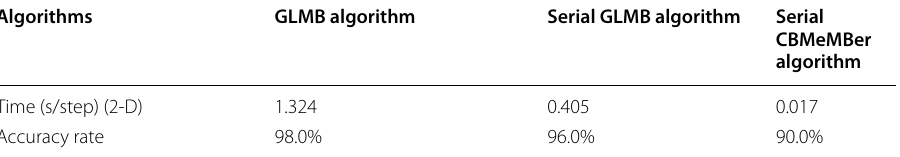
Table 2 Performance analysis of algorithms